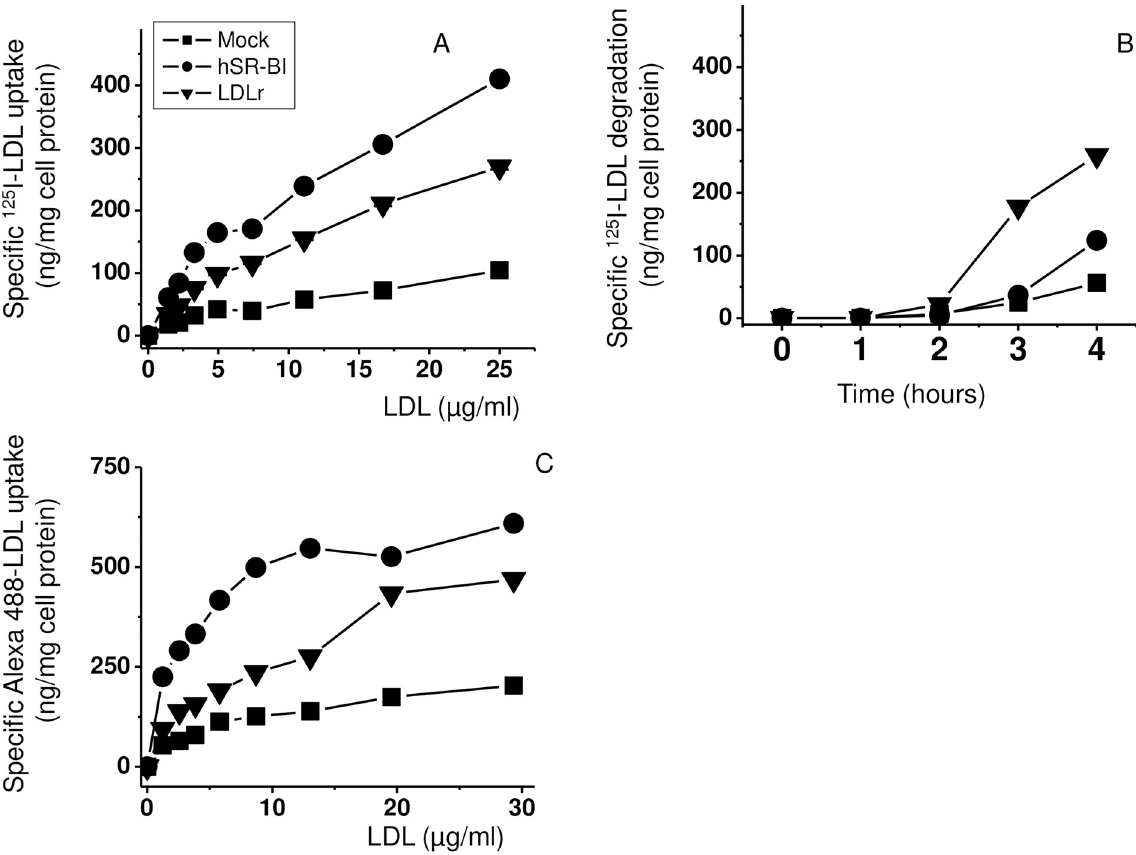
Fig 1. LDL uptake and degradation in HeLa cells. Mock transfected, hSR-BI overexpressing and LDLr overexpressing HeLa cells were incubated with various concentrations of 125 I labeled LDL (A) and Alexa 488-labeled LDL (C) for 2 h at 37 C˚ (A, C) or with 5 μ g/ml of 125 I-LDL in the absence or presence of 20-fold excess of unlabeled LDL while collecting media and measuring LDL degradation at 0, 1, 2 and hours (B). The specific dose-response/time course data points represent the difference in radioactive counts measured in the presence and absence of 20-fold excess of unlabeled LDL. In all cases (Panels A, B and C), the differences in both specific LDL uptakes and LDL degradation were statistically significant at 3 hours with p < 0.001 between all three groups: hSR-BI-HeLa versus LDLr-HeLa or versus